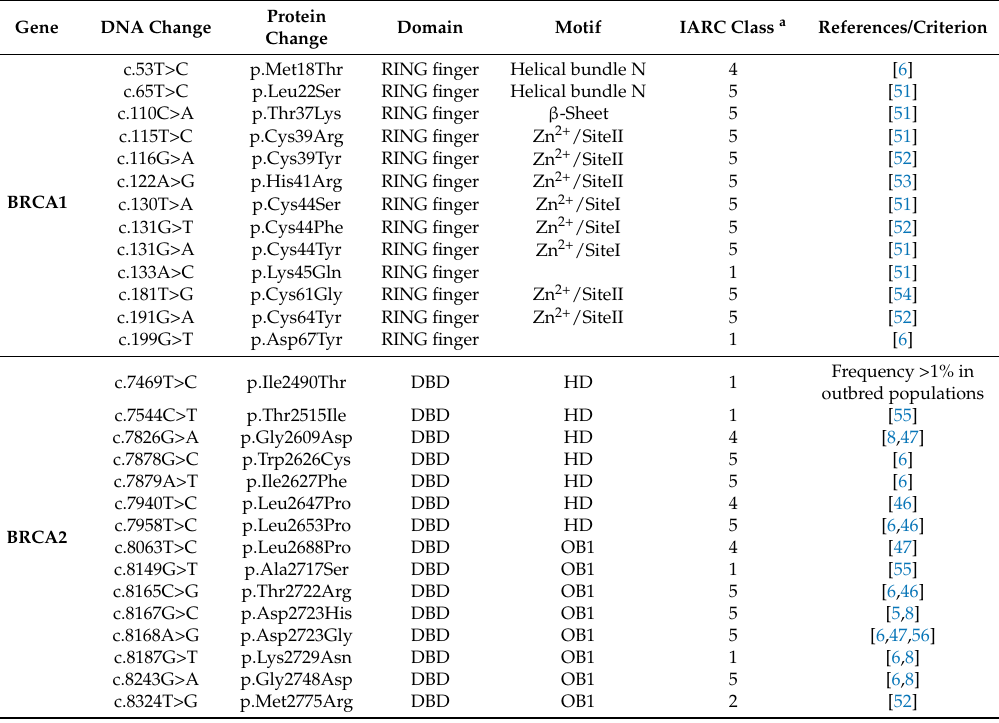
Figure 1. Diagram showing the location of specific motifs of the BRCA1 and BRCA2 proteins and the variants analyzed. Non-pathogenic variants (class 1 and class 2) are shown in green, pathogenic variants (class 4 and class 5) are shown in red, and VUS are shown in black. DBD, DNA binding domain. HD, helical domain. OB1, oligonucleotide/oligosaccharide binding fold 1. VUS, variants of uncertain significance. Table 1. Variants of validation